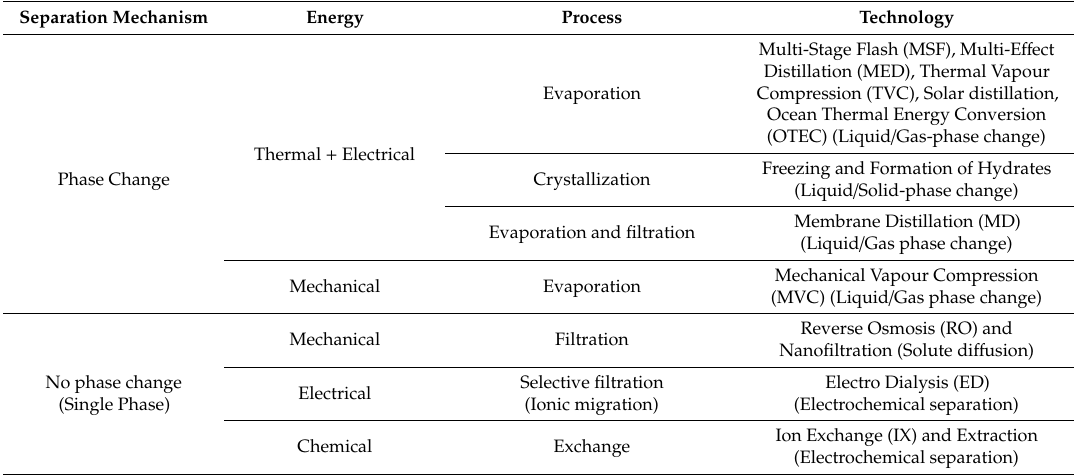
Table 2. Classification of general desalination technologies